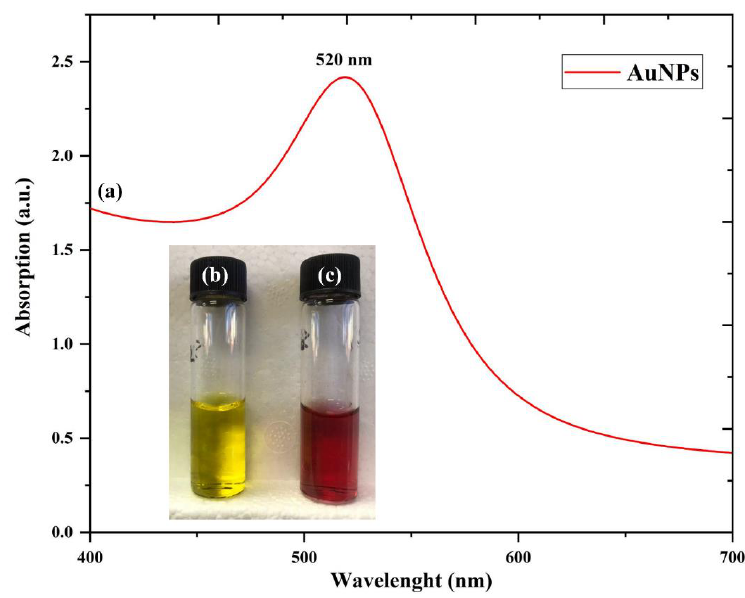
Figure 3. ( a ) Surface plasmon resonance (SPR) of AuNPs, which have a diameter of about 18.5 nm, ( b ) HAuCl 4 suspension and ( c ) AuNPs